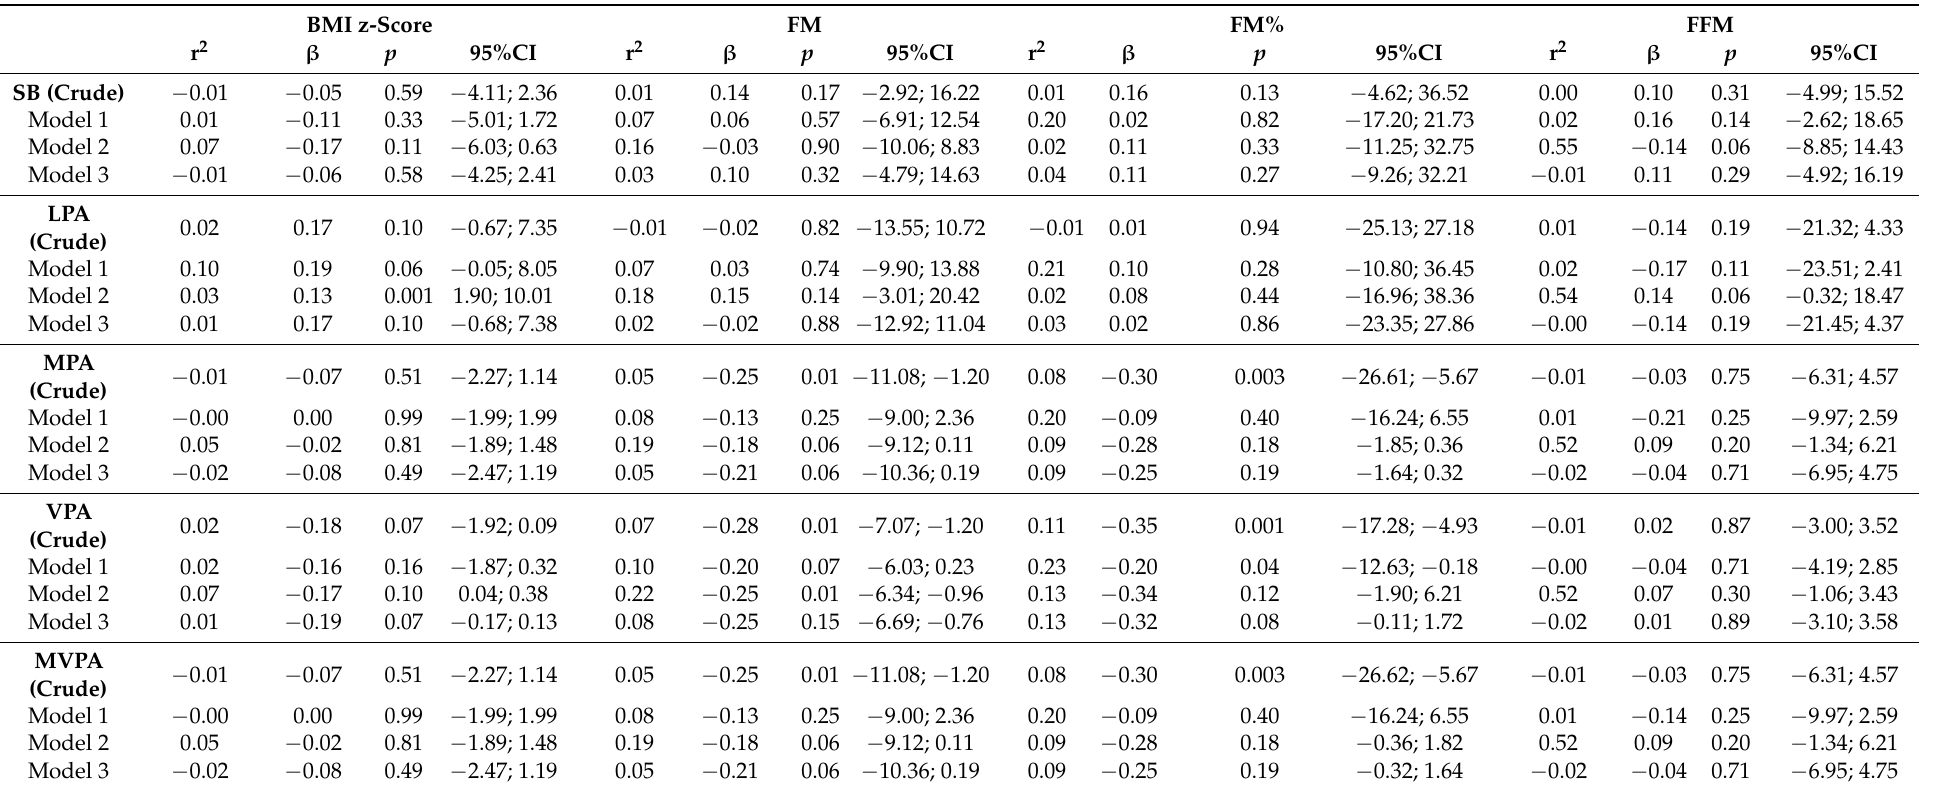
Table 4. Associations between body fatness components and physical activity